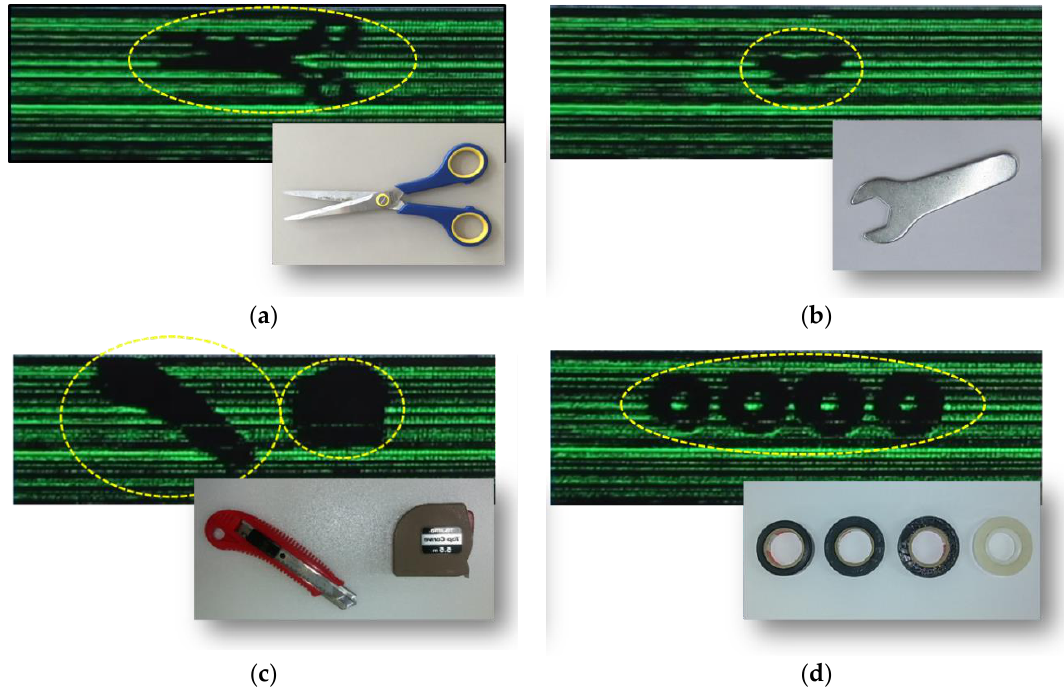
Figure 9. Captured images of THz real-time videos for various samples and photographs of the samples: ( a ) Scissors; ( b ) A wrench; ( c ) A pocket knife and a tapeline; ( d ) Adhesive tapes. Insets: Photographs of the samples in each image.